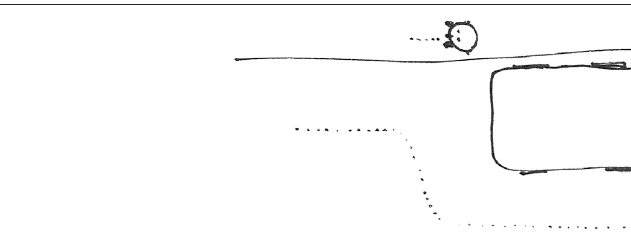
FIGURE 7 | The overtake maneuver.